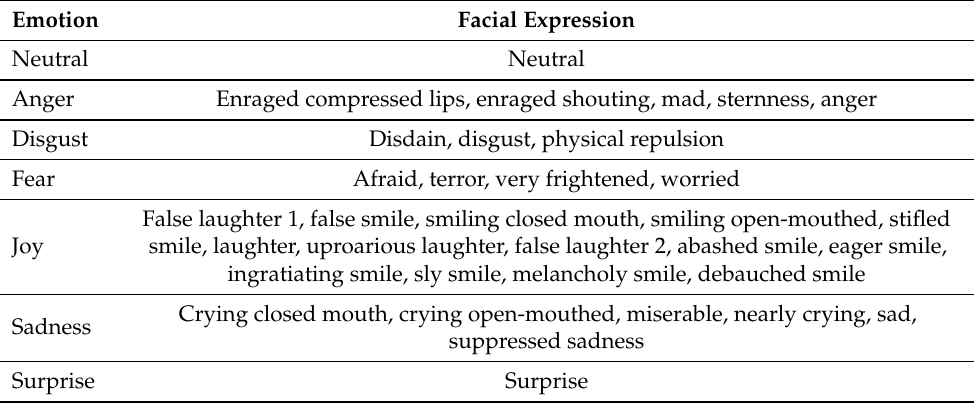
Table 1. Emotions associated with each facial expression according to Gary Faigin classification.